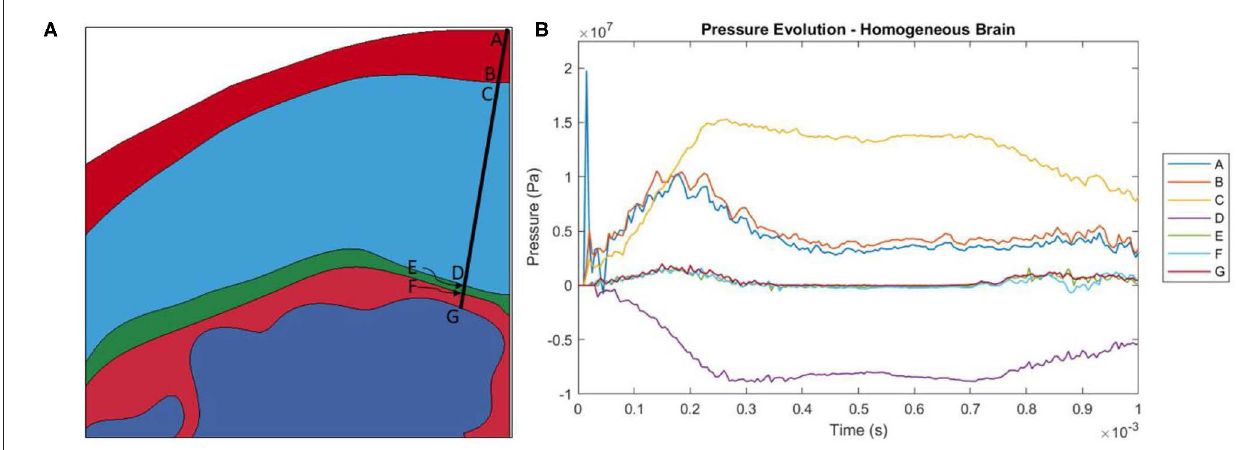
FIGURE 3 | (A) Locations at which pressure history was measured. Locations A and B are the locations where the pressure wave enters and leaves the skin. C and D are the locations where the pressure wave enters and leaves the skull. E and F are the locations where the pressure wave enters and leaves the dura mater. Finally, G is where the pressure wave enters the brain. (B) Evolution of pressure in the head model with a homogeneous brain.